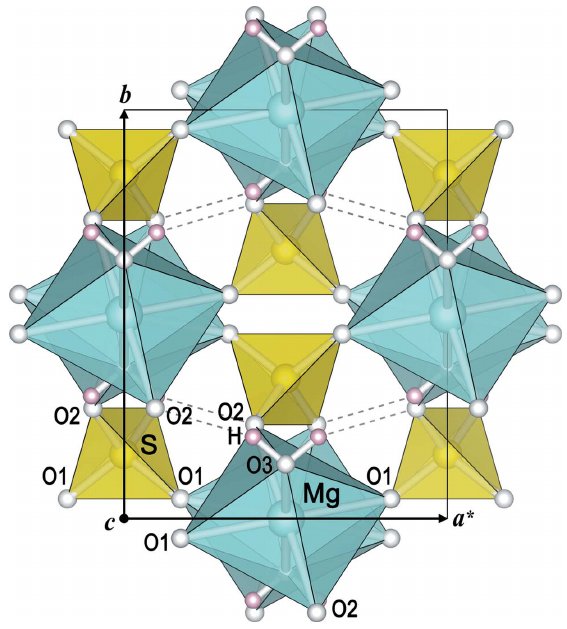
Figure 1 Crystal structure of kieserite (MgSO 4 (cid:2) H 2 O) at 15 K, projected along the c axis, i.e. along the octahedral–tetrahedral chains.